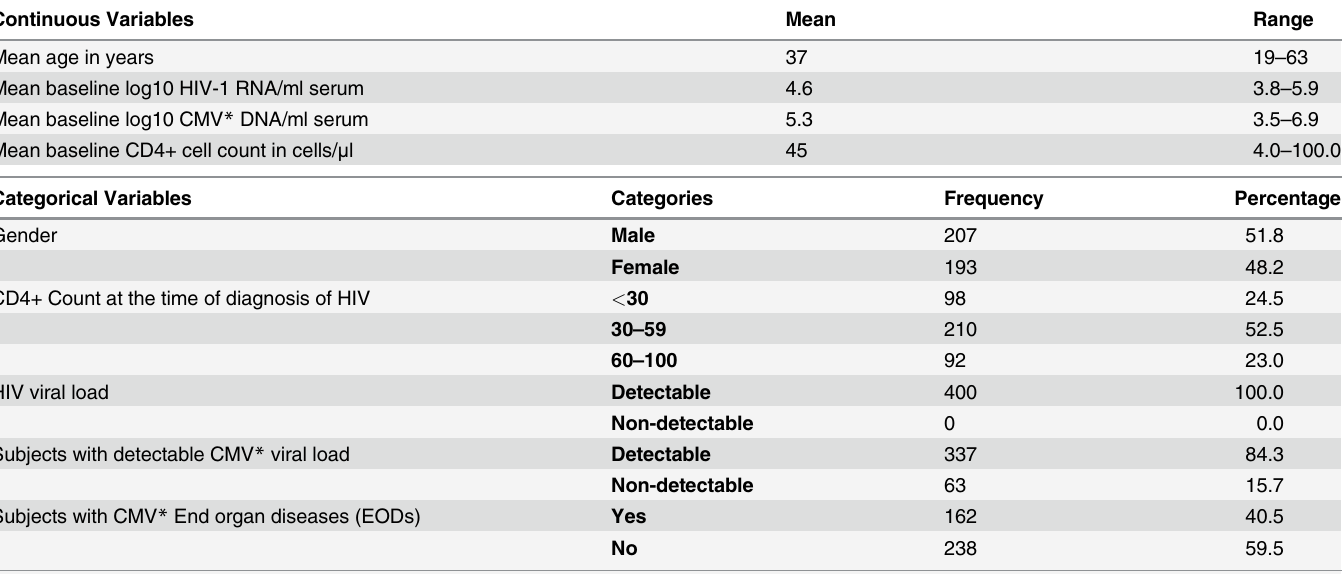
Table 1. Distribution of the baseline characteristics of the participating HIV/AIDS patients (N = 400). Continuous